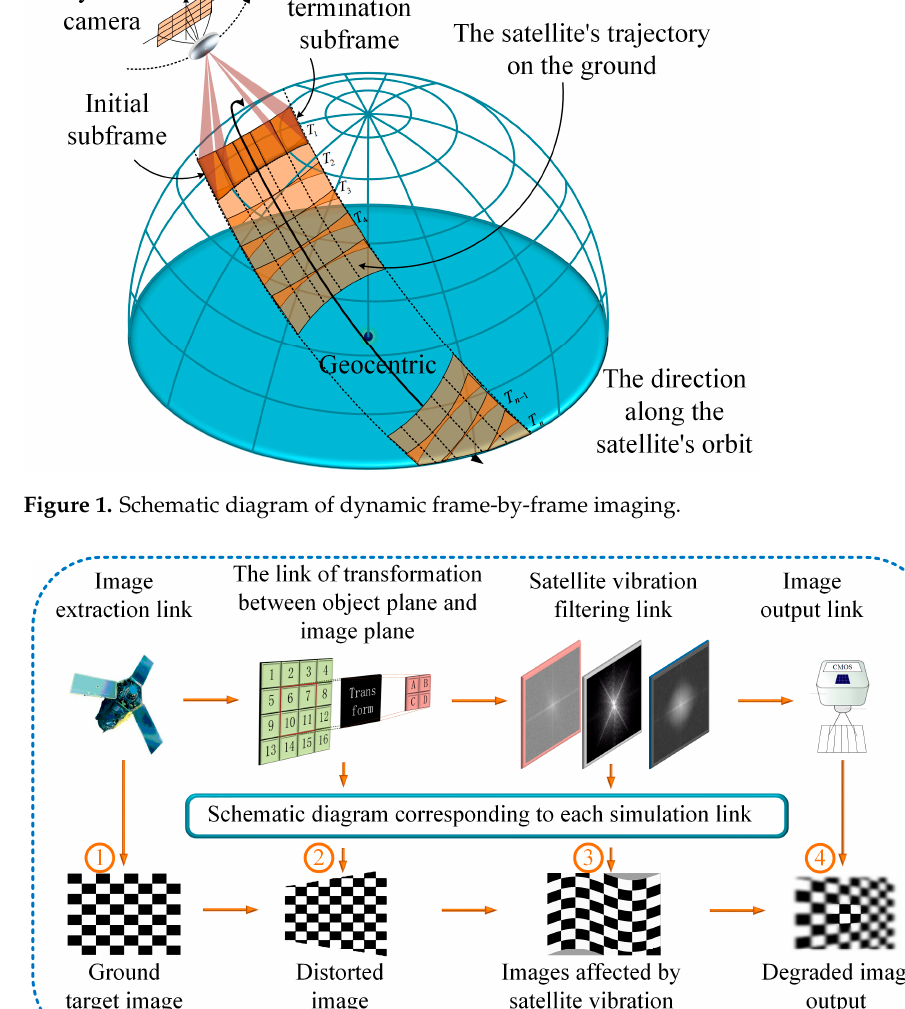
Figure 1. Schematic diagram of dynamic frame-by-frame imaging.